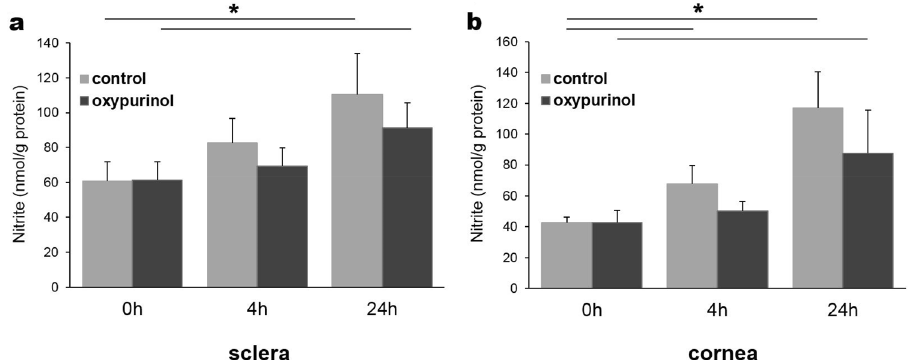
Figure 4. Nitrate reduction activity in sclera and cornea homogenates. Sclera ( a ) and cornea ( b ) homogenate was mixed with cofactors such as NADPH, UDP glucuronic acid, NAD + , NADH and glutathione with